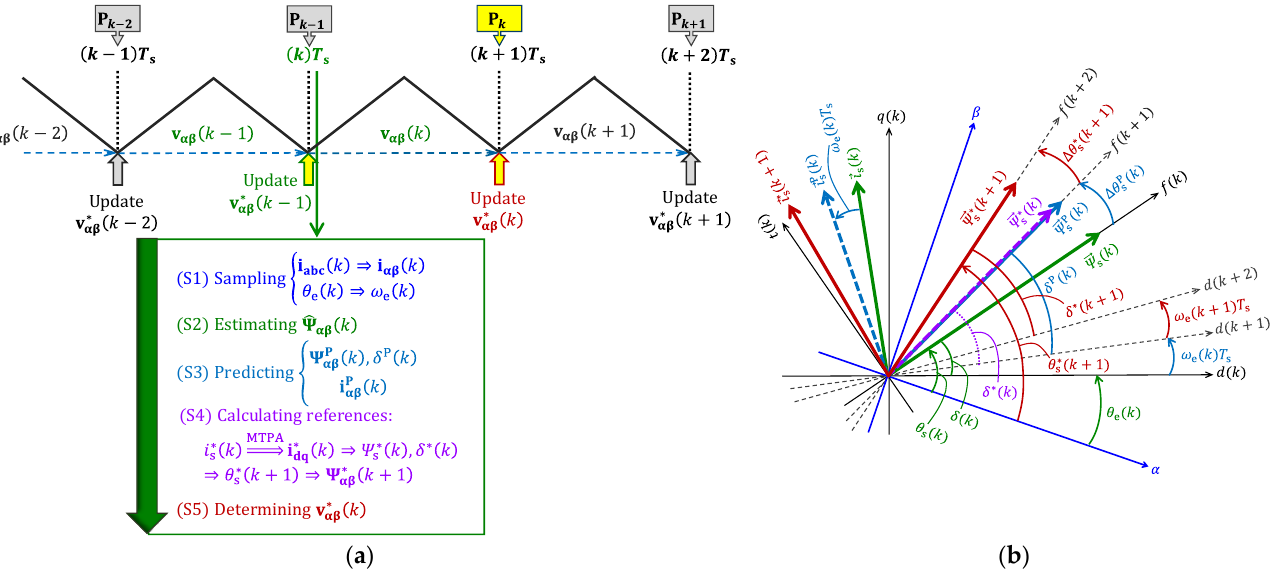
Figure 2. ( a ) Control timeline and ( b ) phasor diagram analysis of proposed DB-CFVC in digital implementation based on the one-step delay compensation.